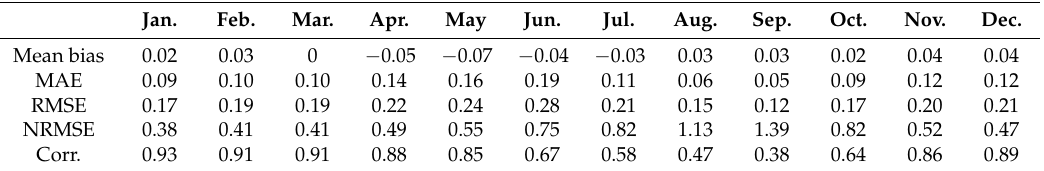
Figure 6. Eleven-year averages of the monthly anomalies of sea ice concentration from satellite observations and the predictions of the DNN with BMA2 ensemble for the Kara and Barents Seas during 2006–2016. Table 7. Validation statistics of the monthly averages of sea ice concentration predicted by DNN with BMA2 ensemble for the Kara and Barents Seas during